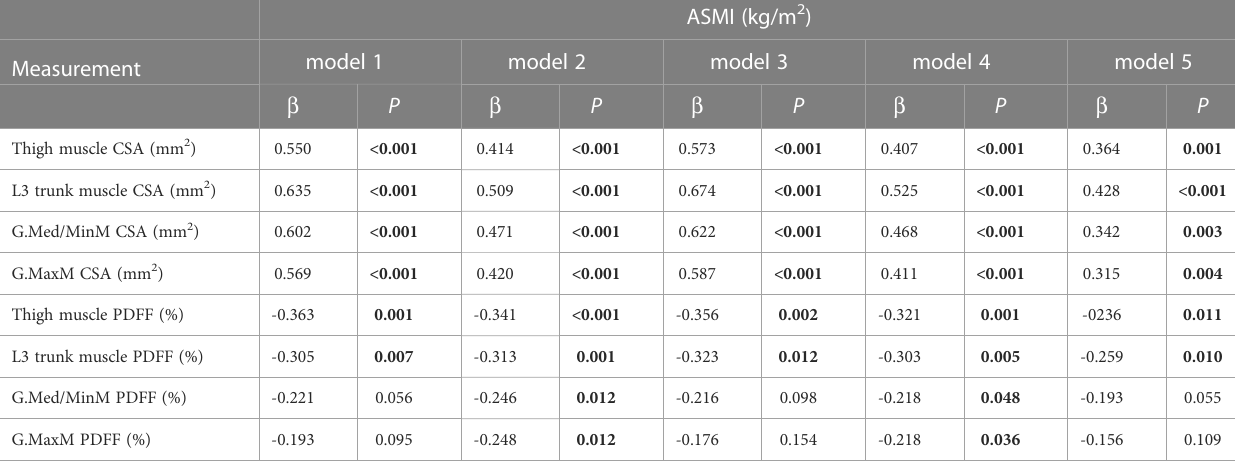
TABLE 4 Independency of muscle measurements and